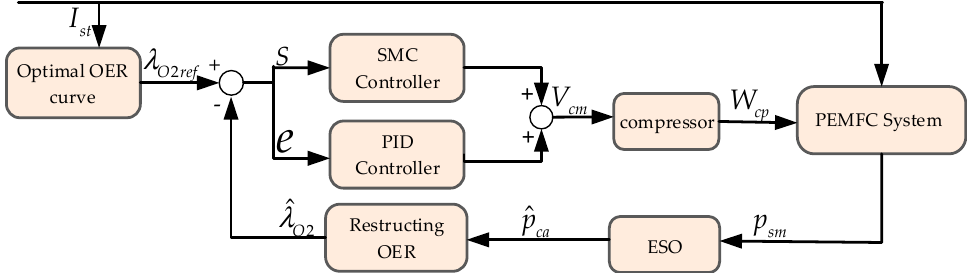
Figure 5. SMC and PID cascade control algorithm block diagram.